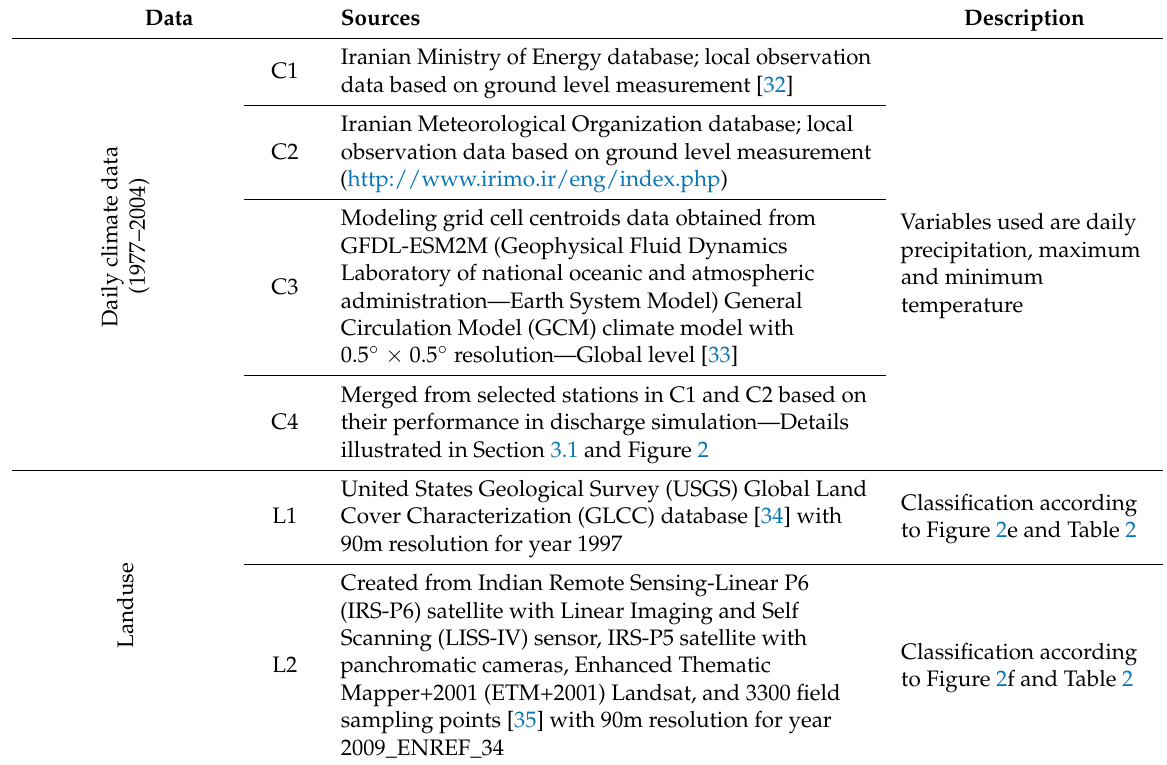
Table 1. Description of climate and land use data for the Karkheh River Basin (KRB). Data Sources Description